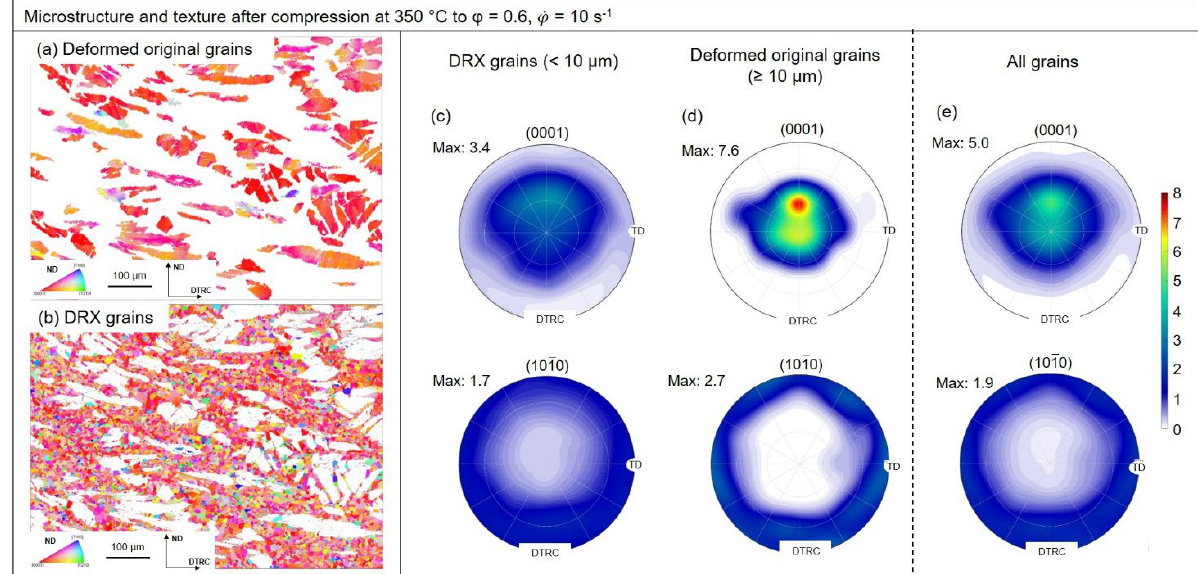
Figure 6. EBSD maps and pole figures of the ZAX210 alloy after hot deformation at 350 °C (equivalent logarithmic strain 0.6, strain rate 0.1 s − 1 ): ( a ) EBSD map of deformed original grains, ( b ) EBSD map of DRX grains, ( c ) (0001) and 1010 pole figures of DRX grains, ( d ) (0001) and 1010 pole figures of deformed original grains, and ( e ) (0001) and 1010 pole figures of all grains.